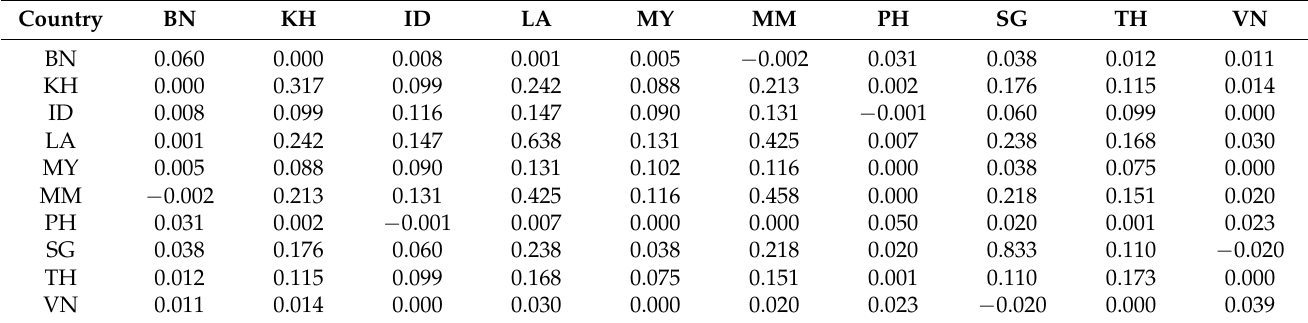
Table A4. The distance covariance of alternatives according to indicator between C1 and C2.